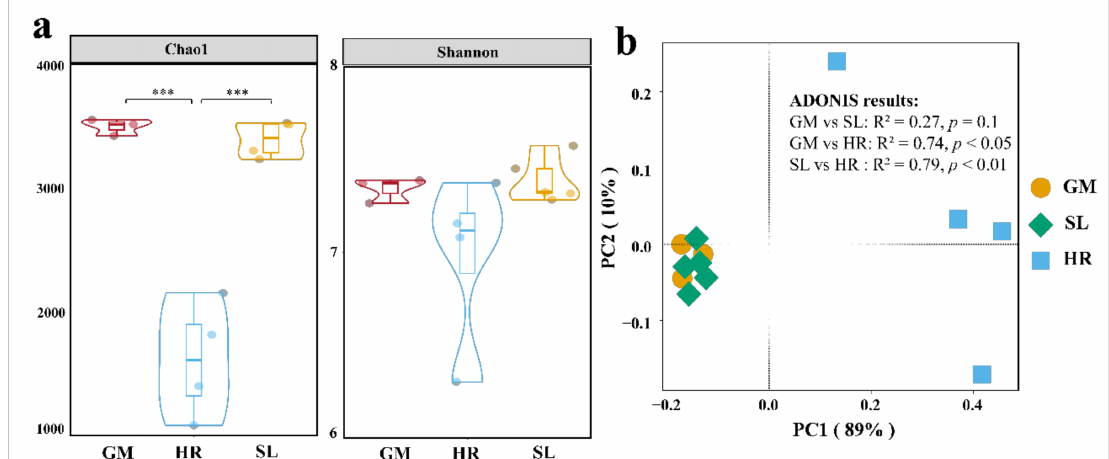
Figure 2. Alpha and beta diversity of water samples in a coal mining subsidence lake and its connected river. ( a ) Chao 1 and Shannon diversity indices; ( b ) principal coordinates analysis (PCoA); SL: subsidence lakes; GM: coal gangue mountain waters; HR: Huihe River. *** p <